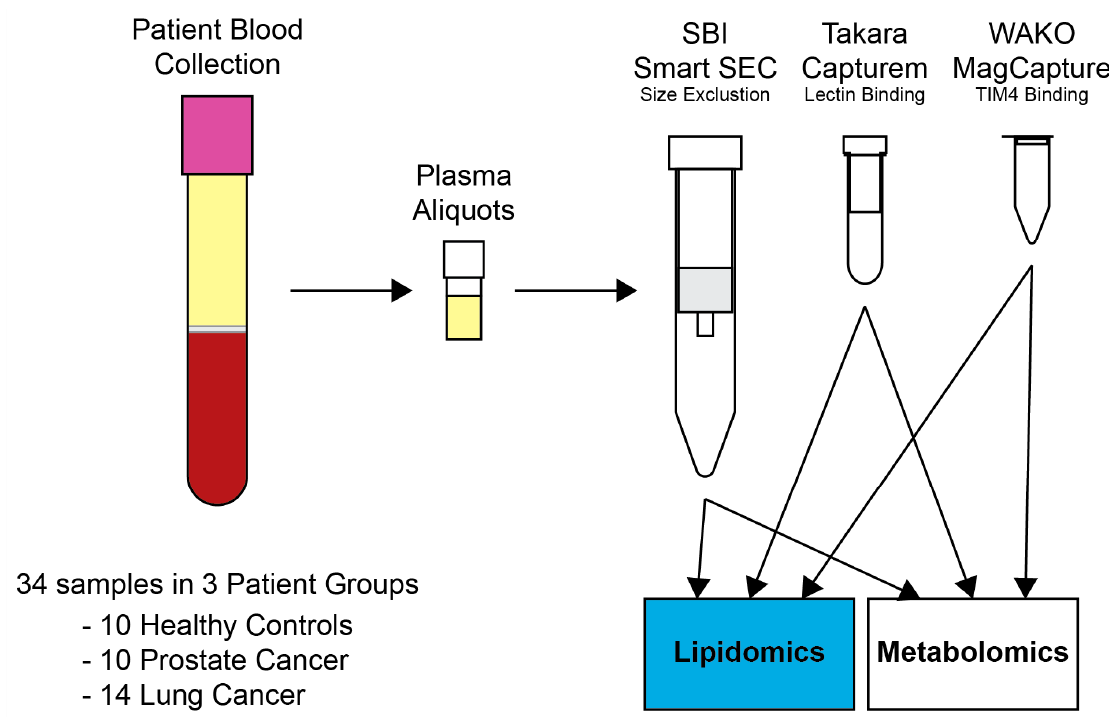
Figure 8. Outline of sample collection, storage, exosome extraction, and omic analysis.